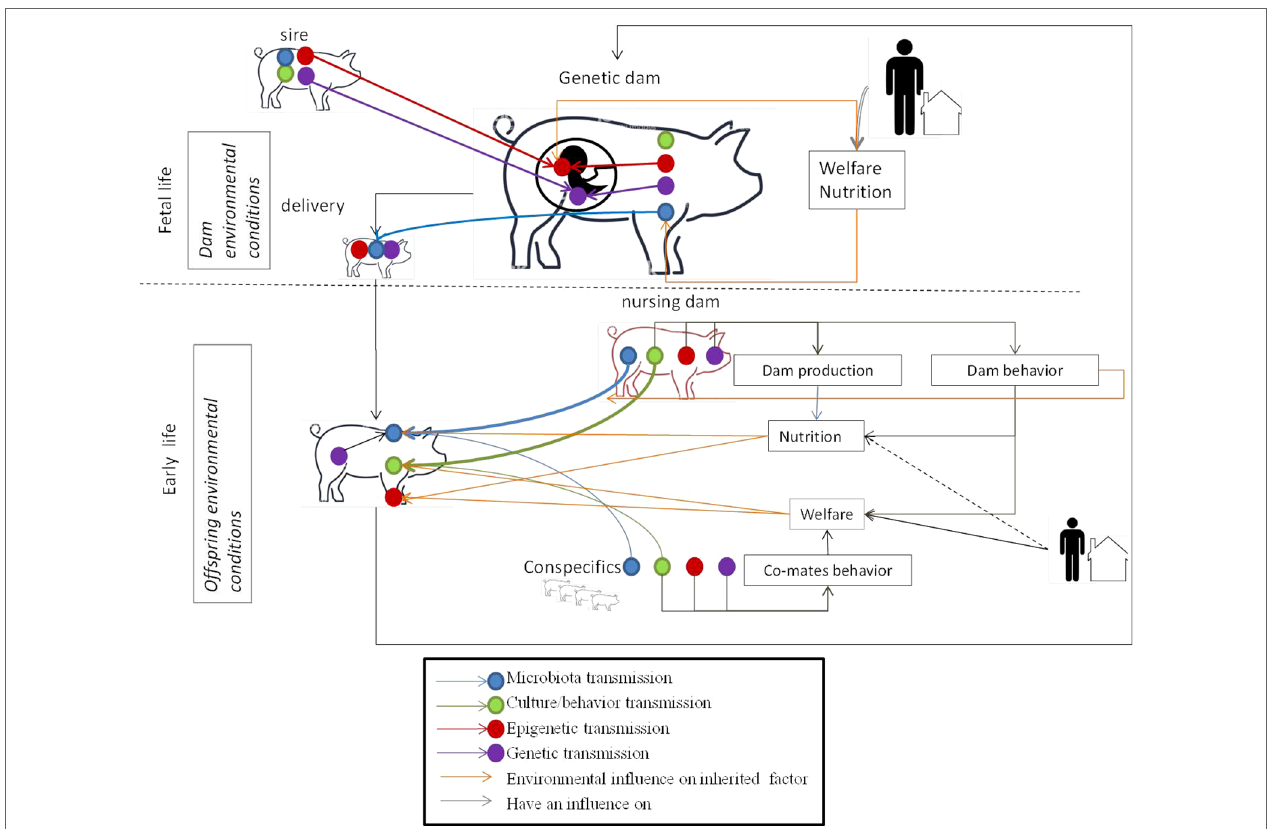
FIGURE 2 | Key moments for the transmission of the different inherited factors and environmental influences during the life of the animal. Fetal life : offspring receive DNA and epigenetic marks from their father and mother. The welfare and nutrition of the genetic dam has an influence on the epigenetic marks of the fetus. The housing and nutrition of the dam have an influence on her microbiota. Her microbiota will be transmitted to her offspring during delivery. Early life : the young learn culture/behavior from conspecifics (might include the sire in some livestock schemes) and the nursing mother. The welfare of the young influences their behavior. Welfare depends on the breeder by positive contact with the young, housing conditions, and dam behavior which is under genetic, epigenetic, and inherited behavior control. The young share their microbiota with their nursing dam and conspecifics. Microbiota transmission from the nursing dam is facilitated by dam behavior which is under genetic, epigenetic and inherited behavior control. The microbiota is modified by the young animal’s diet, given by the dam for mammalian species, which is under genetic, epigenetic and to a lesser extend behavior control and influenced by the genetics of the young. Epigenetic marks in young animals are modified by welfare and nutrition